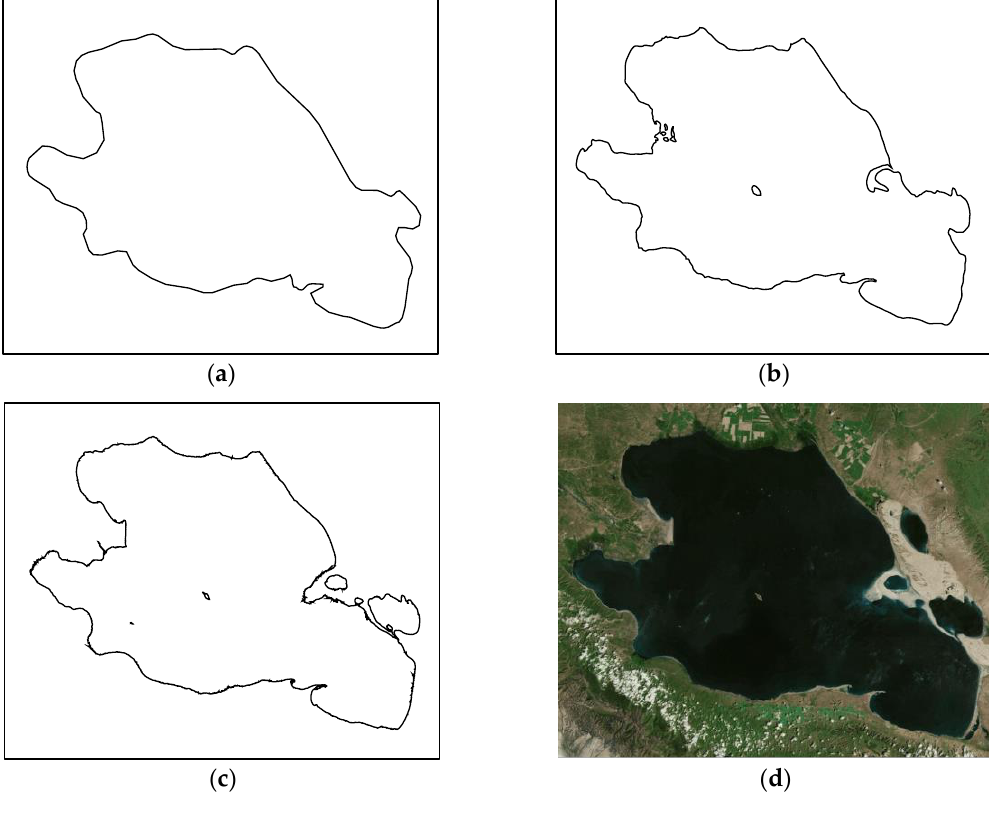
Figure 1. Qinghai Lake in multiple representations ( a ) Simple polygon, ( b ) holed polygon, ( c ) multipolygon; and ( d ) Bing maps.